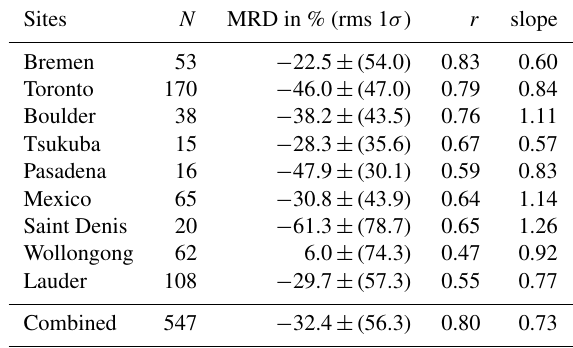
Table 3. Summarized results of the comparison between FTIR-NH 3 and IASI-NH 3 total columns within the coincidence criteria thresh- old ( x diff < 25km, t diff < 90min). N is the number of averaged total columns, MRD is the mean relative difference (in %), r and slope are the correlation coefficient and slope of the linear regression. Sites